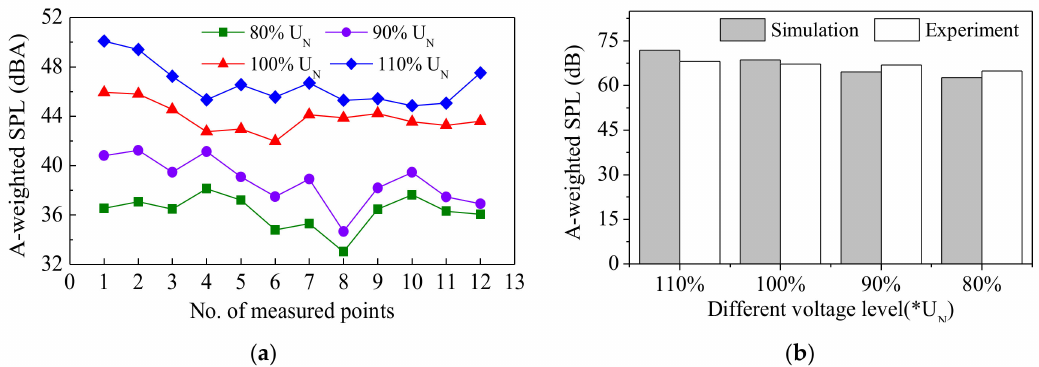
Figure 16. Comparison of A-weighted SPL under different no-load voltages. ( a ) A-weighted SPL at each point; ( b ) Average equivalent A-weighted SPL.